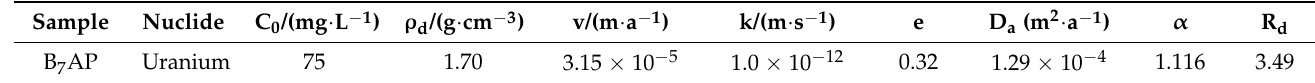
Table 2. Diffusion coefficient of uranium in integrated buffer material (B 7